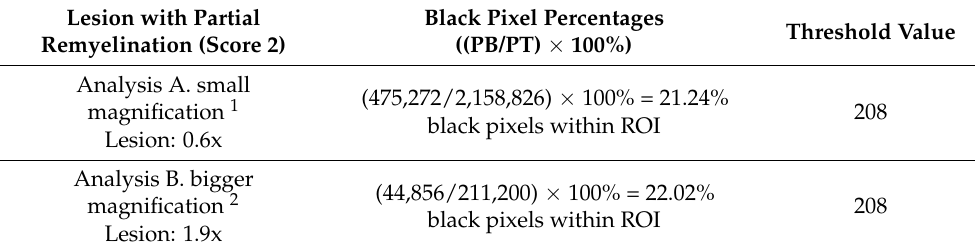
Table 1. Quality analysis of lesion images taken at different